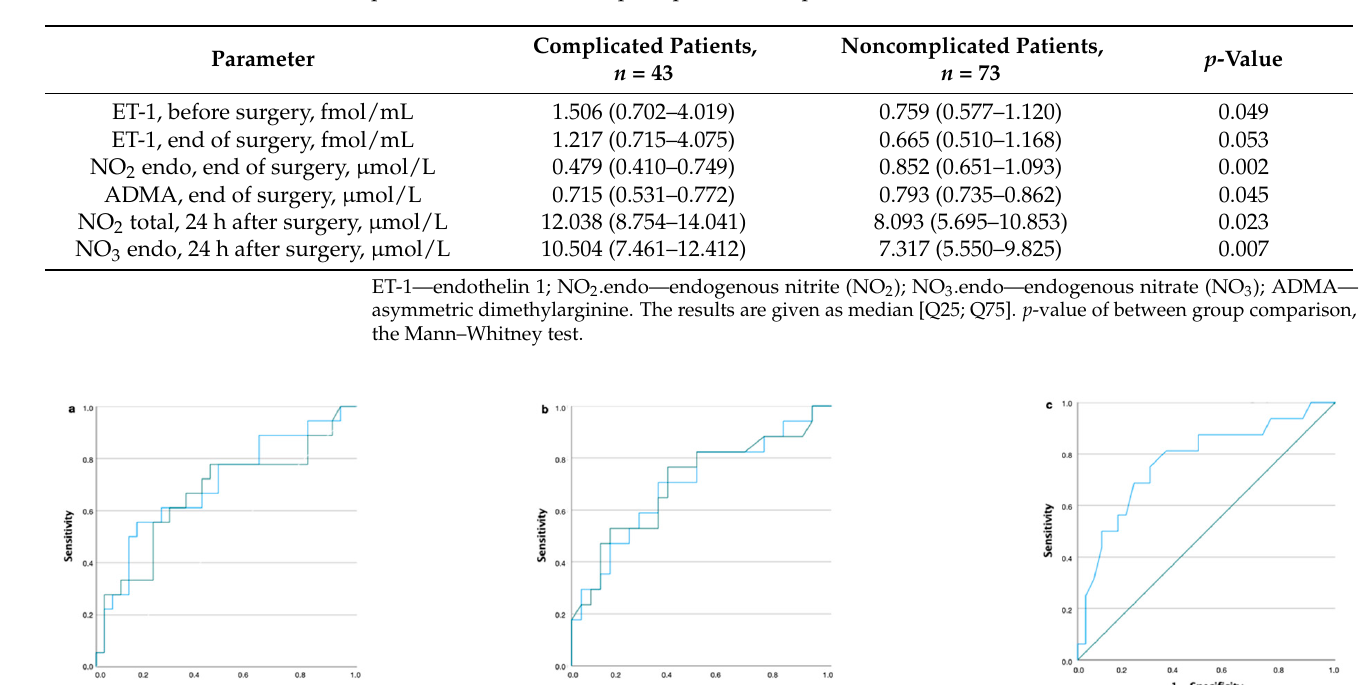
Table 5. Characteristics of endothelin-1, nitric oxide metabolites, and ADMA concentrations in patients with or without postoperative complications.